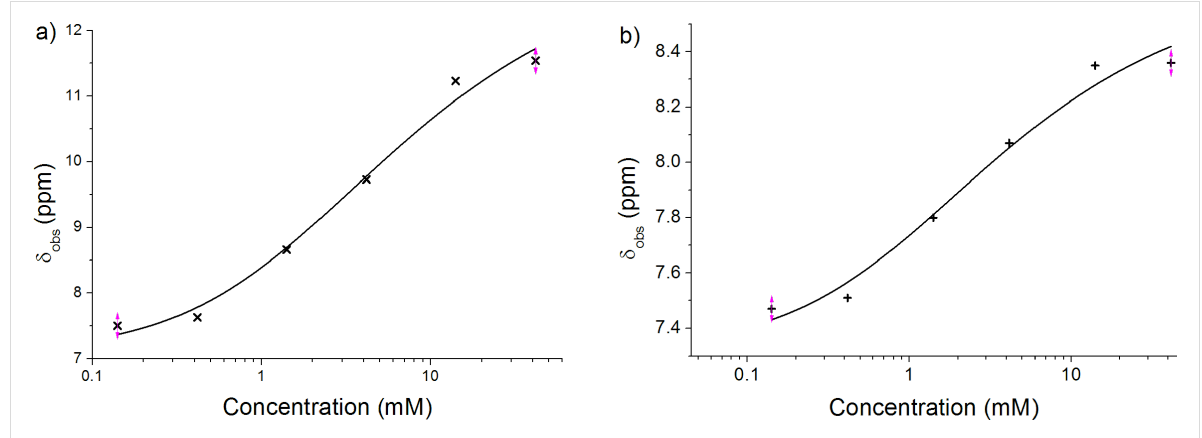
Figure 3: The concentration dependence of (a) the NH 1 H NMR chemical shift and (b) the vinyl proton chemical shift for compound 2 in d 6 -benzene. The line is the regression fit of Equation 1 to the